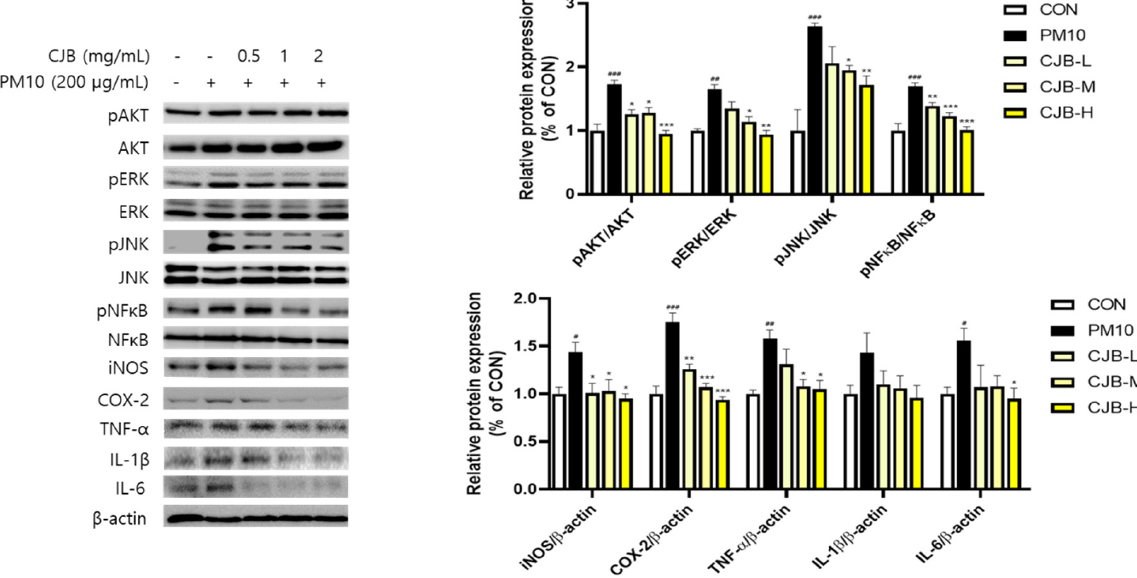
Figure 5. The expression of inflammatory proteins in PM10-treated A549 cell lines. All values are expressed as the mean ± SEM. A p -value under 0.05 was considered statistically significant. # , ## , and ### indicate statistical significance compared to the CON group, and *, **, and *** indicate statistical significance compared to the PM10 group. CON, normal control; PM10, negative control; CJB-L, CJB at 0.5 mg/mL; CJB-M, CJB at 1 mg/mL; CJB-H, CJB at 2 mg/mL.